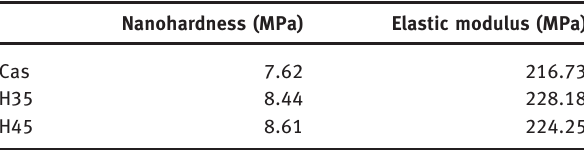
Table 5: The nanohardness and elastic modulus in non-HIPed and HIPed specimens.